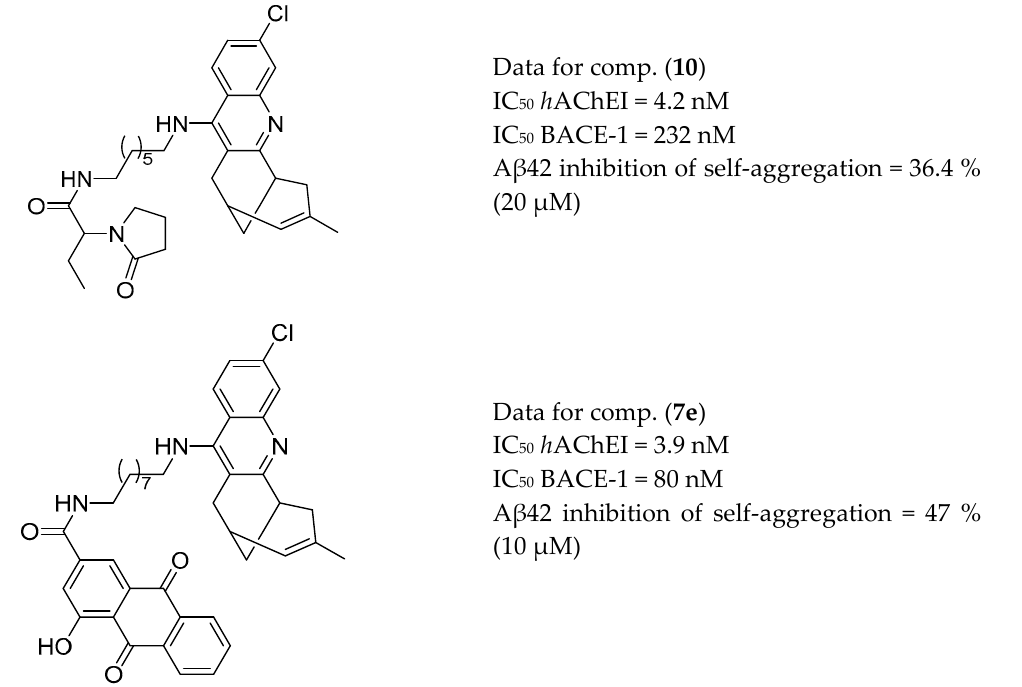
Figure 5. The most active levetiracetam-huprine and rhein-huprine hybrids from [139] and [141].